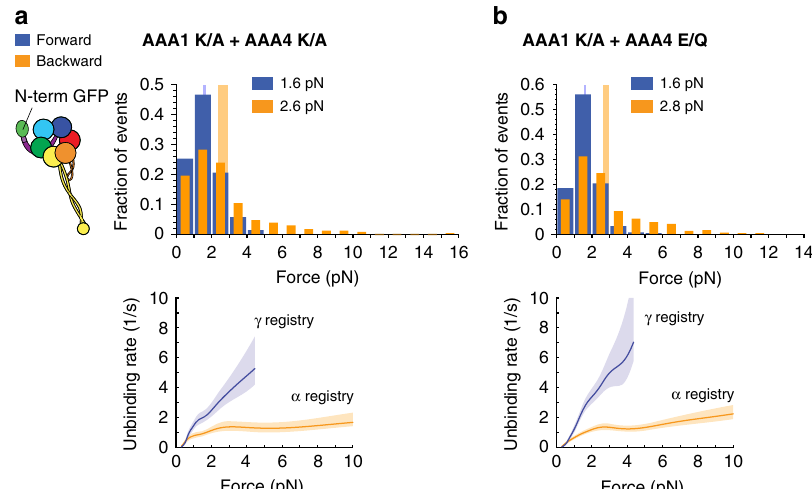
Fig. 5 The effects of AAA4 on dynein-MT binding require AAA1-ATP binding. a (Left) Schematic of dynein with GFP fused to the N-terminus. (Right) Histogram of forward (blue) and backward (orange) unbinding forces for the AAA1 K/A + AAA4 K/A-GFP-Dyn1 331kDa double mutant measured in the presence of 1 mM ATP. The respective mean values are noted. The vertical bands represent 95% CIs for the means (forward: [1.5, 1.7] pN, backward [2.4, 3] pN). (Bottom) Unbinding rate vs. force derived from the data above. The shaded areas are the 95% CIs for the mean rates, which were estimated by bootstrapping. b Same as in a , but for the AAA1 K/A + AAA4 E/Q-GFP-Dyn1 331kDa double mutant (95% CIs [1.6, 1.7] and [2.6, 3] pN). The number of events in the forward and backward directions: ( a ) (276,229) and ( b ) (575, 569). Source data are provided as a Source Data fi le.